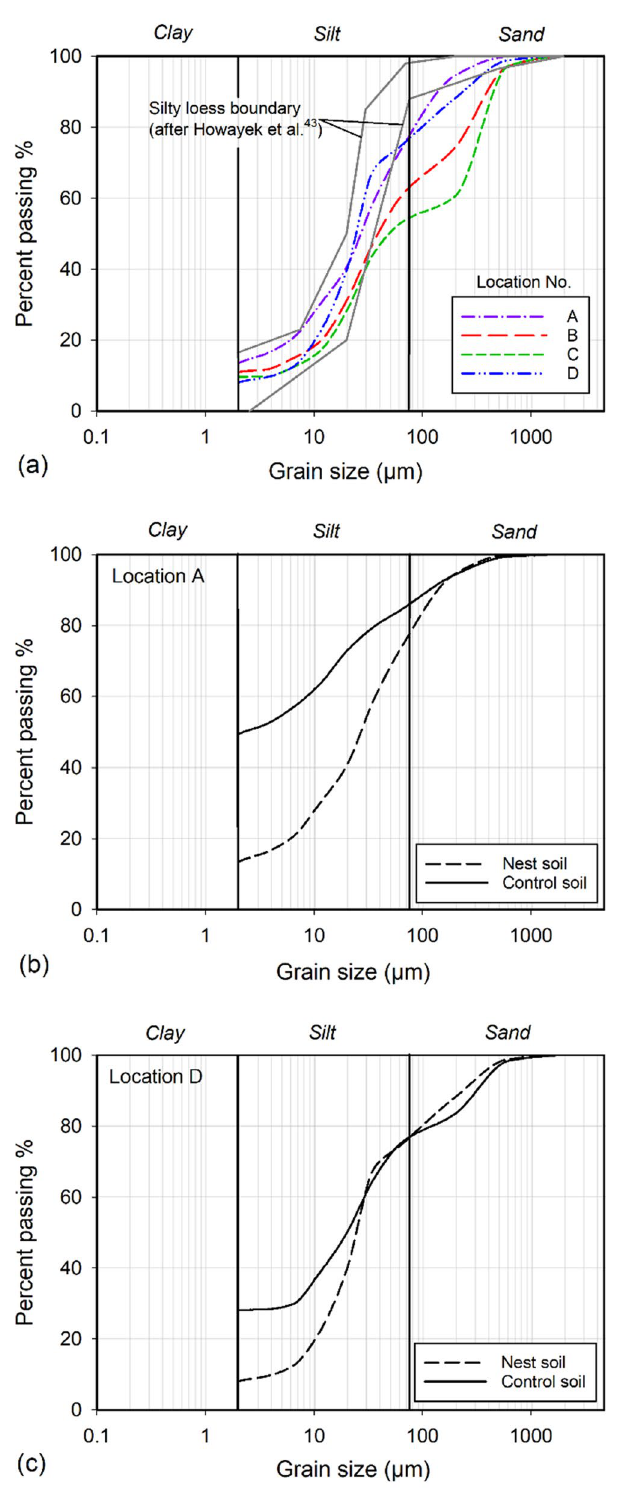
Figure 5. Grain size distributions of ( a ) the nest soil samples from different locations, ( b ) the nest soil sample compared to the control soil at location A, and ( c ) the nest soil sample compared to the control soil at location